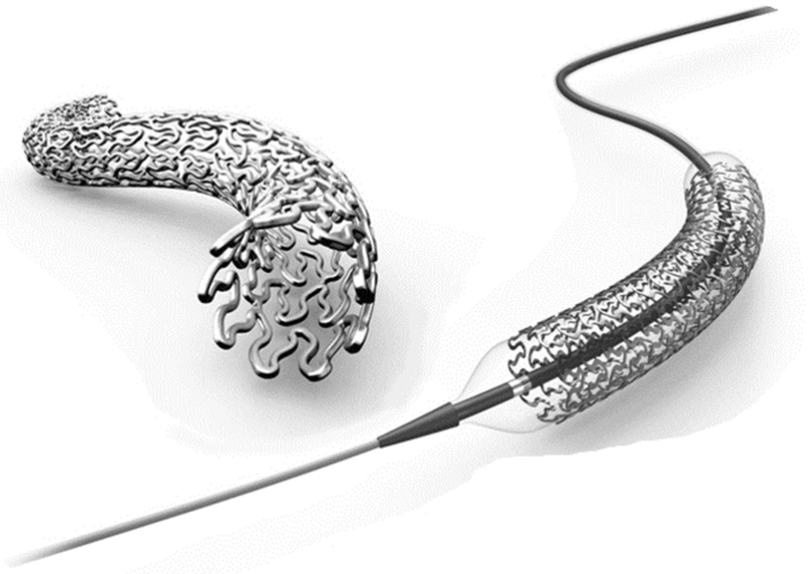
Figure 2. A laser-cut balloon expandable vascular stent and the delivery set. The stent is crimped onto a tightly-folded balloon catheter for delivery. After correctly positioning the catheter across the stricture, the balloon is inflated with saline to place the stent, and then deflated for removal of the delivery set (courtesy of Genoss, Inc., Suwon, Korea).